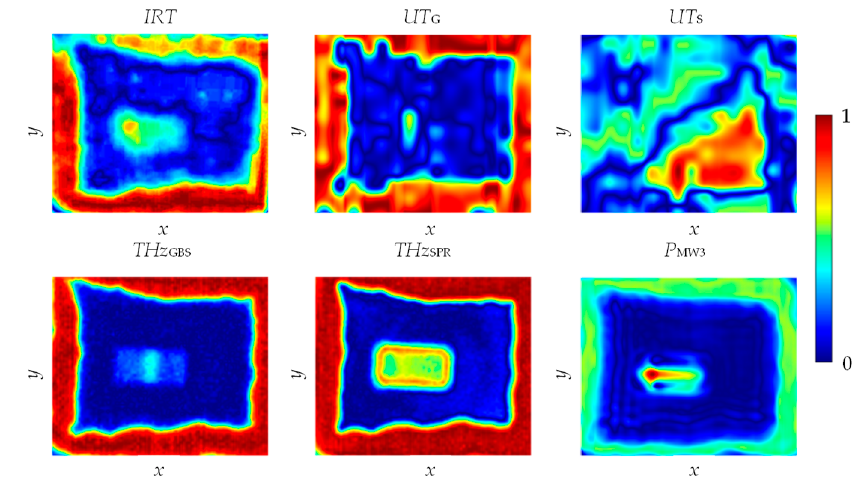
Figure 17. Selected multiple inspection results after the data registration process.